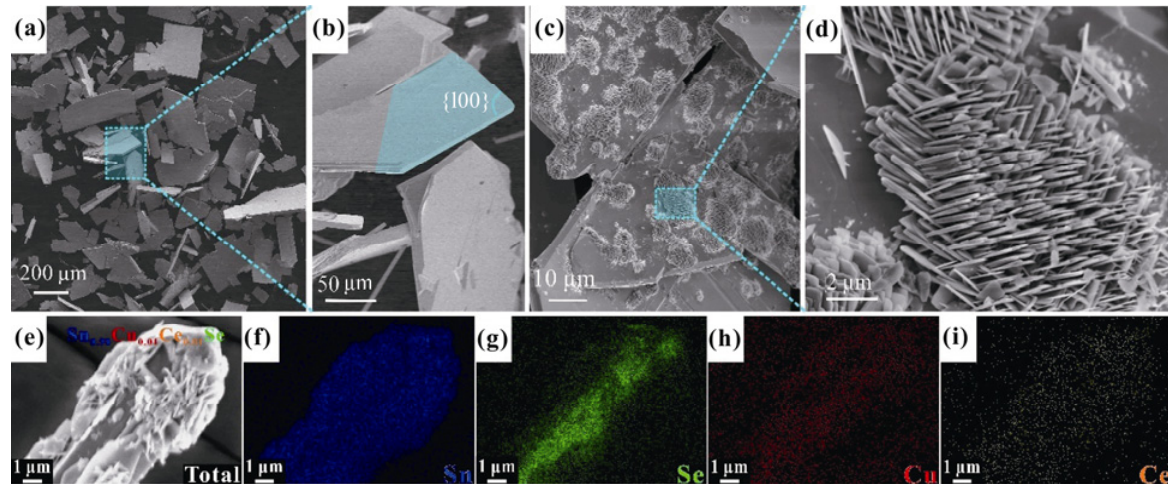
Fig. 3 (a) SEM image of synthesized powders for x , y = 0. (b) Magnified view of framed area in (a) to show {l00} surface. (c) Typical SEM image of synthesized powders for x , y = 0.01 with nano-sized second-phase arrays. (d) Magnified SEM image of framed area in (c) to show morphology of nanoprecipitations. (e) SEM image of Sn 0.98 Cu 0.01 Ce 0.01 Se sample for EDS analysis. EDS elemental mappings of (f) Sn, (g) Se, (h) Cu, and (i)